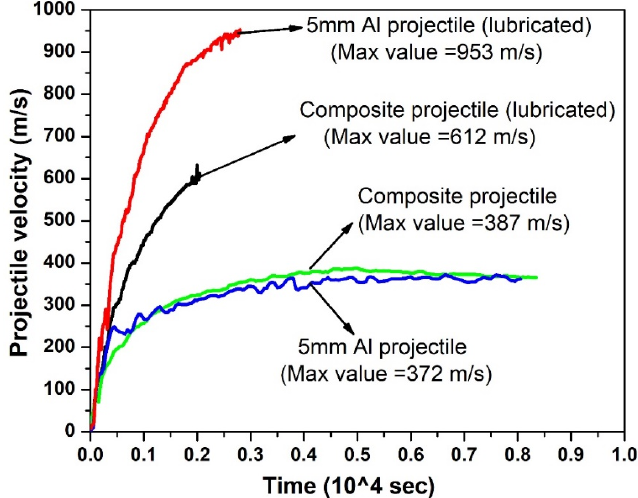
Figure 4. Graph showing the comparison of projectile velocity using lubrication and without lubrication for 5 mm aluminum and composite projectiles.